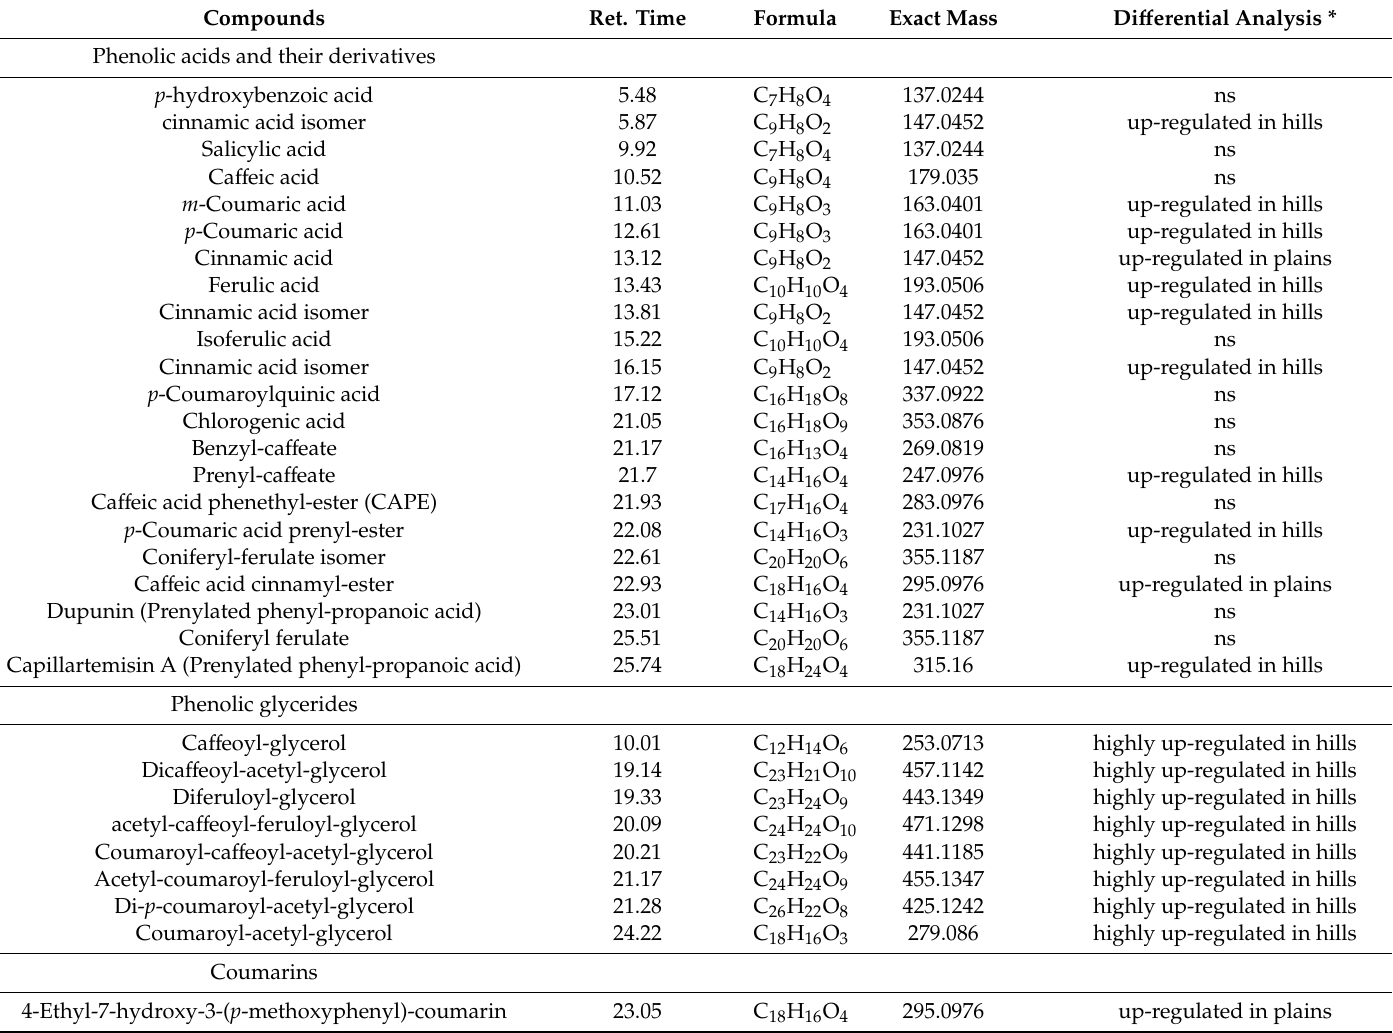
Table 4. Tentative identification of compounds based on Compound Discoverer